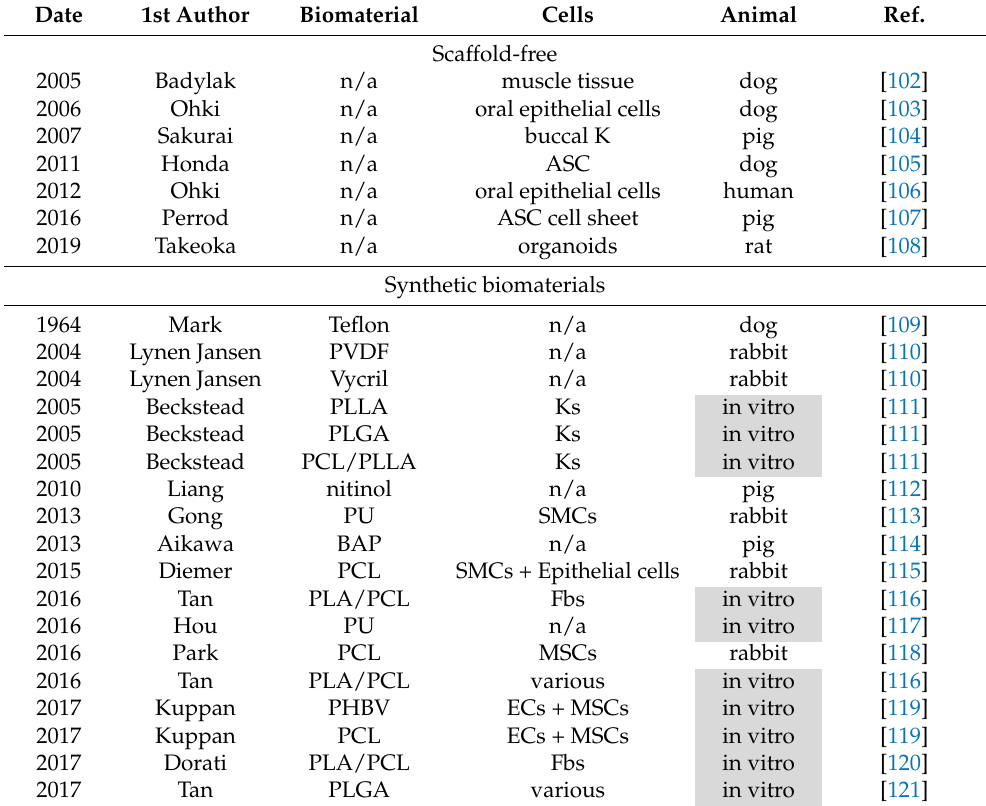
Table 1. Scaffold-free and synthetic biomaterial protocols for esophageal